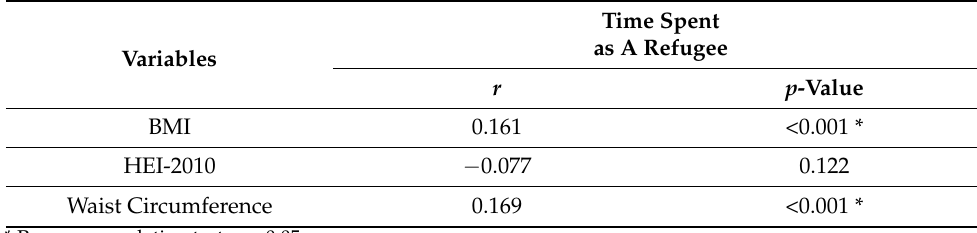
Table 5. The relationship between BMI, HEI-2010 score, waist circumference, and time spent as a refugee. Variables